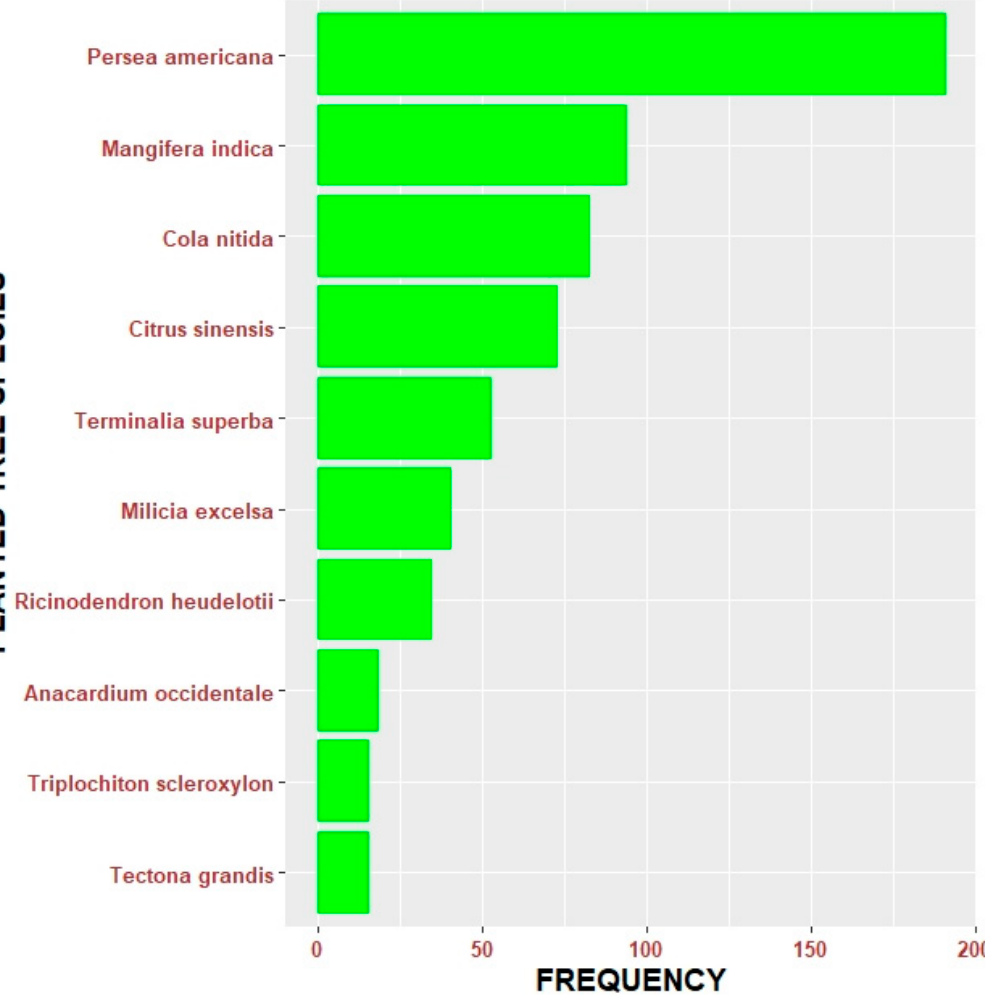
Figure 3. Tree species most frequently planted by farmers on cocoa farms in Côte d’Ivoire. The location of the cocoa production areas significantly affected the number of tree species that farmers planted on cocoa farms (Table 2), with the least being planted in the center, south, and west, and the most in the east (Table 2). The age of the farmers significantly affected the number of species planted as more trees were planted by older farmers ( p = 0.017; Table 2), while gender, household or family size, matrimonial status, farm size, education level, migration status, farm size, and land tenure status had no effect on the number of tree species planted (Table 2). 3.2. Tree Species Retained on Land Cleared for Cocoa Farming The number of trees retained was highly significantly ( p < 0.001) affected by tree planting experience, while production areas and expected benefits also significantly affected this variable (Table 3). The number of tree species retained when clearing land for cocoa planting increased with benefits and decreased in intensive cocoa-production areas (Table 3). The species that were most retained during land clearance for cocoa farms included timber and indigenous and exotic fruit and nut species, namely Milicia excelsa , Ceiba pentandra (L.) Gaertn. (Malvaceae), Terminalia superba , Triplochiton scleroxylon , Ricinodendron heudelotii , Cola nitida , Adansonia digitata L. (Malvaceae), Khaya ivorensis A.